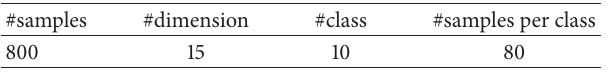
Table 4: Description of rolling element bearing